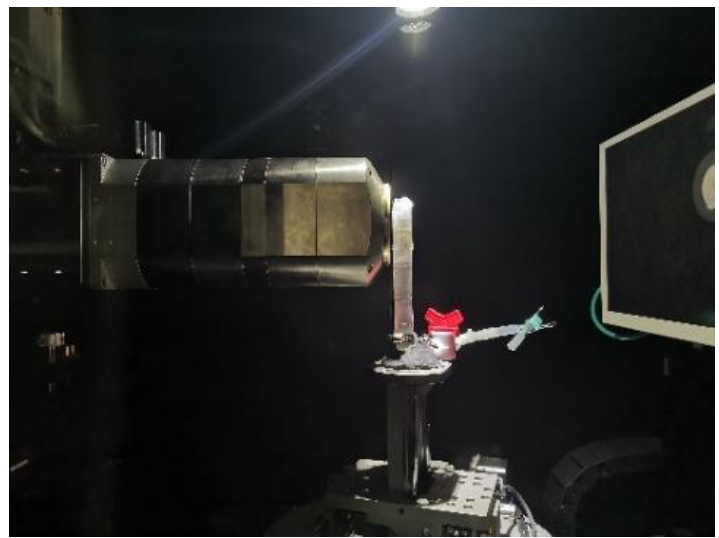
Figure 4. CT scan of the tailings sand sample.